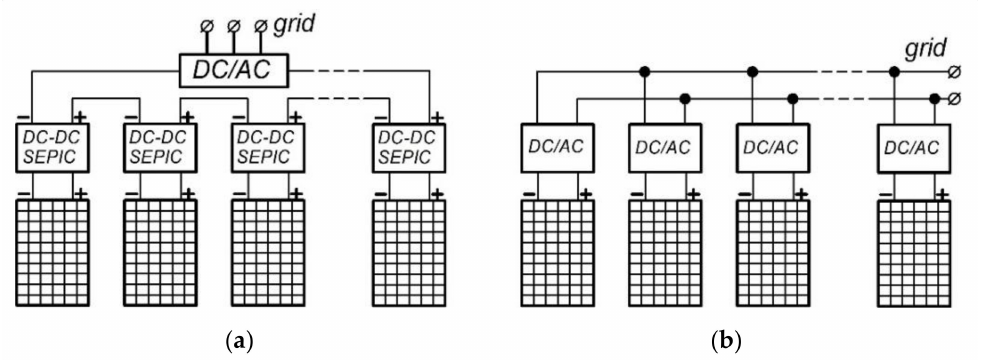
Figure 5. Switching of individual matching converters ( a ) and micro-inverters ( b